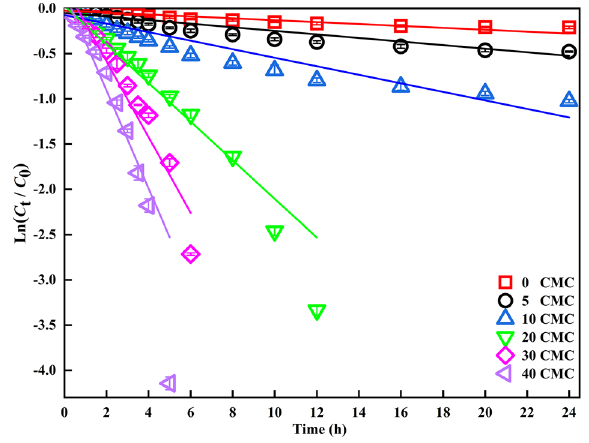
Figure 2. Pseudo-first-order kinetic equation for the conversion of ANT by LMS-HOBt.